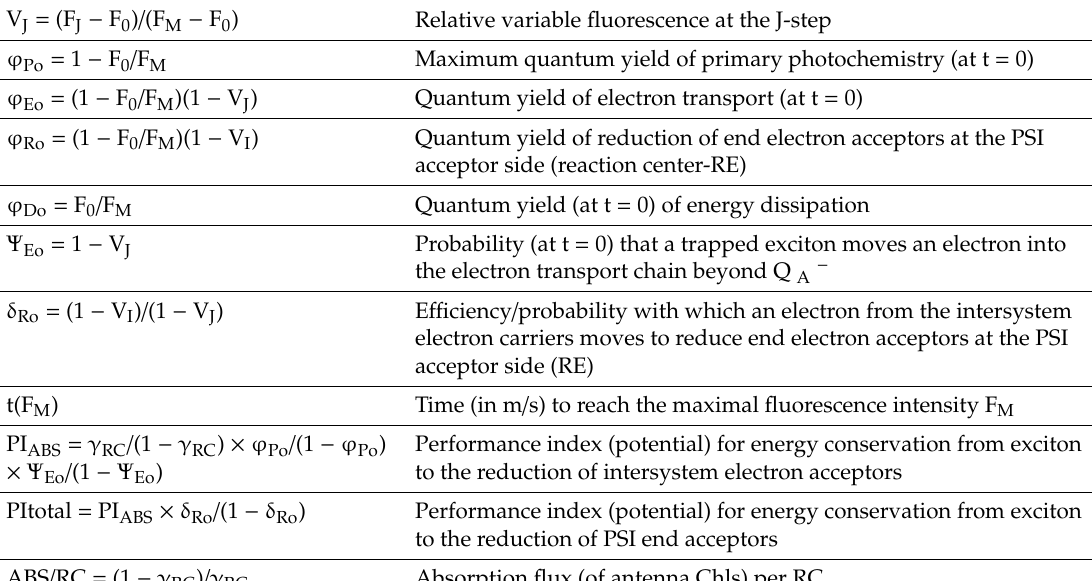
Table 1. The description of fluorescence parameters (after Strasser et al. 2010 [33]), delayed fluorescence (DF), MR820, and gas exchange parameters. All fluorescence parameters are in relative units. RC, reaction